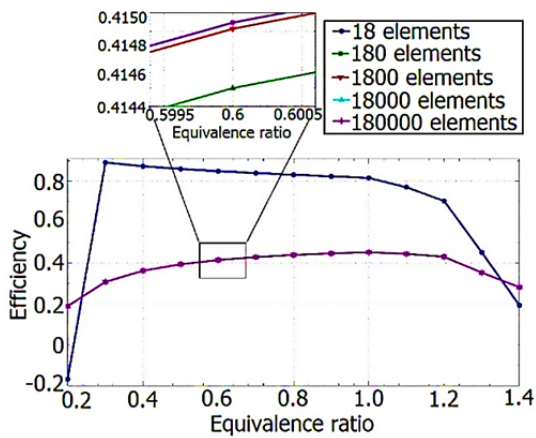
Figure 2. Variation in thermal efficiency with the number of equilibrium states provided using FTT. Evaluation of power developed